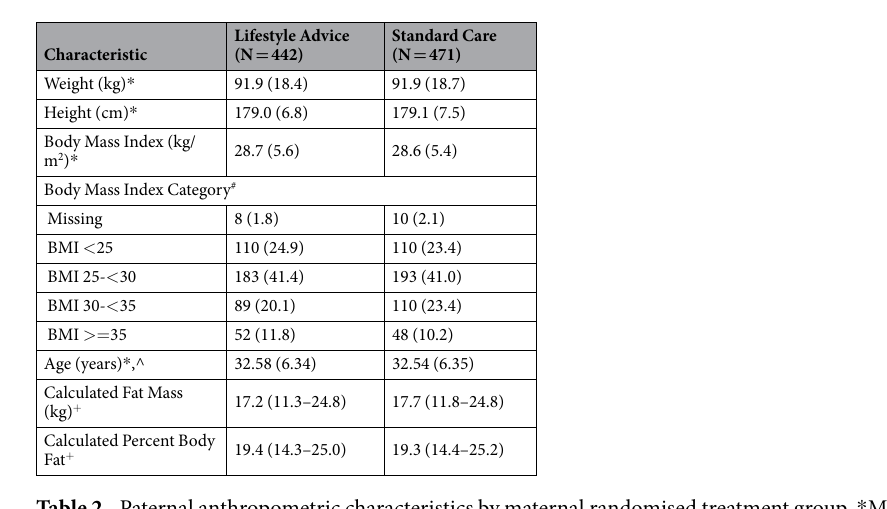
Table 2. Paternal anthropometric characteristics by maternal randomised treatment group. * Mean and standard deviation. + Median and interquartile range. # Number and %. ^Based on a subset of 197 fathers (101 Lifestyle Advice, 96 Standard Care) for whom information on date of birth was